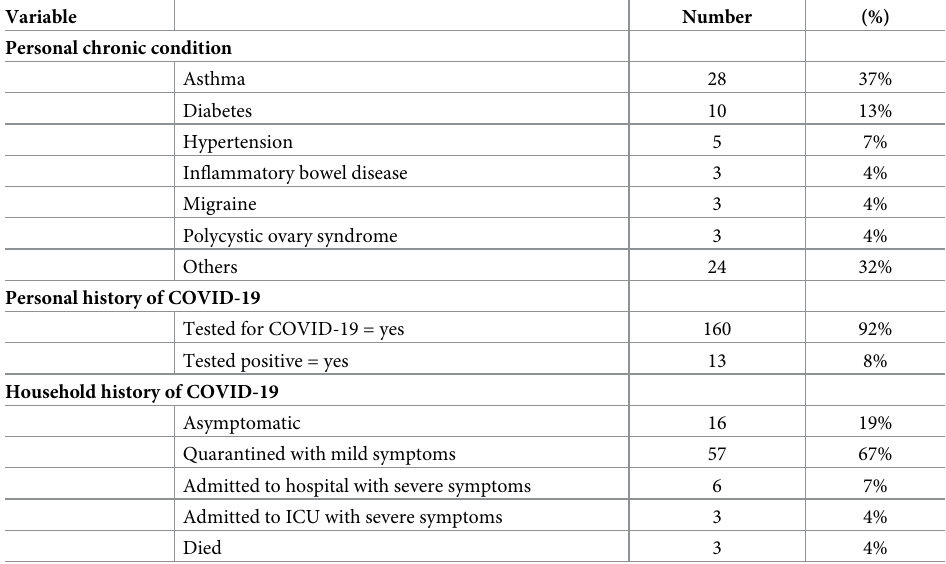
Table 2. Comorbidities and COVID-19 history of the KAP survey